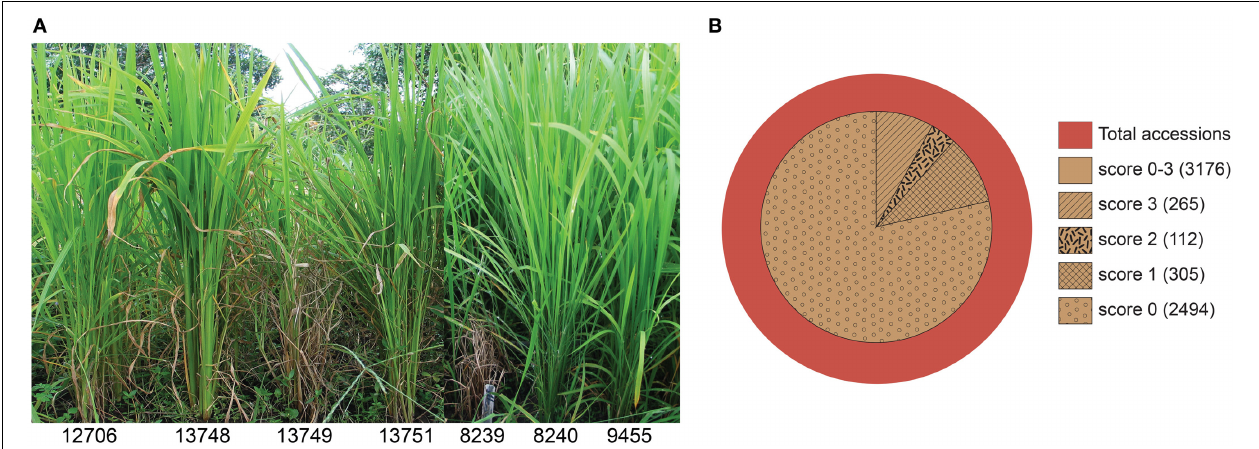
FIGURE 1 | Rice blast resistance screening in the uniform blast nursery. (A) Sample images of rice genotypes showing full blast resistance phenotypes (IRGC 12706, 13748, 13751, 8240, and 9455) in contrast to susceptible genotypes (IRGC 13749 and 8239) in the uniform blast nursery. (B) Summary of rice blast resistance screening in the uniform blast nursery. Inner circle represent the number of